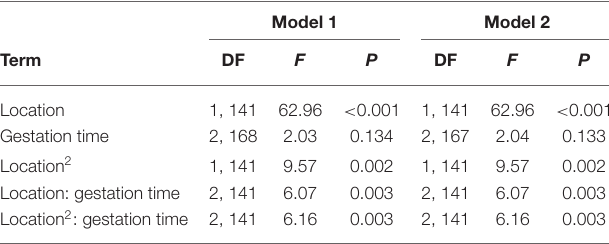
TABLE 3 | Results of the best supported statistical